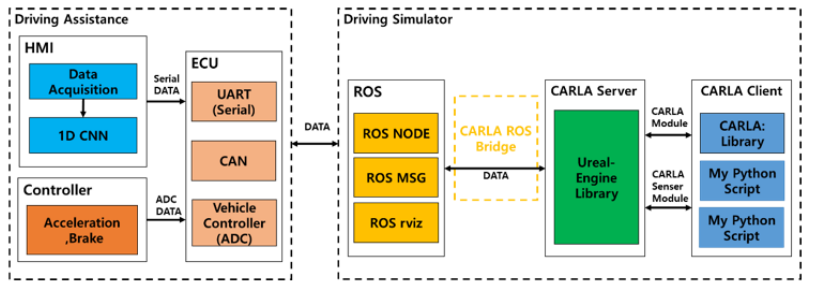
Figure 1. Architecture of driver-assistance system that recognizes the driver’s situation and emotions based on bio-signals.